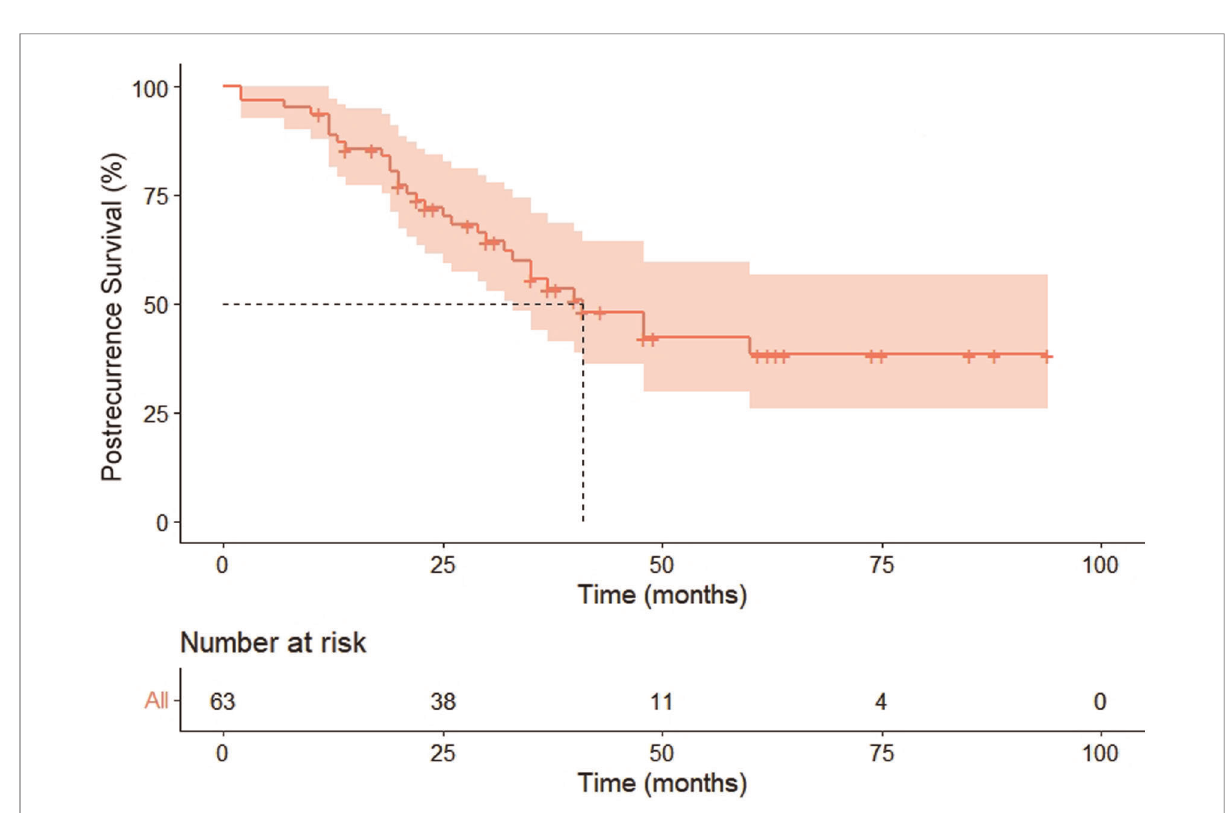
FIGURE 3 Postrecurrence survival of enrolled